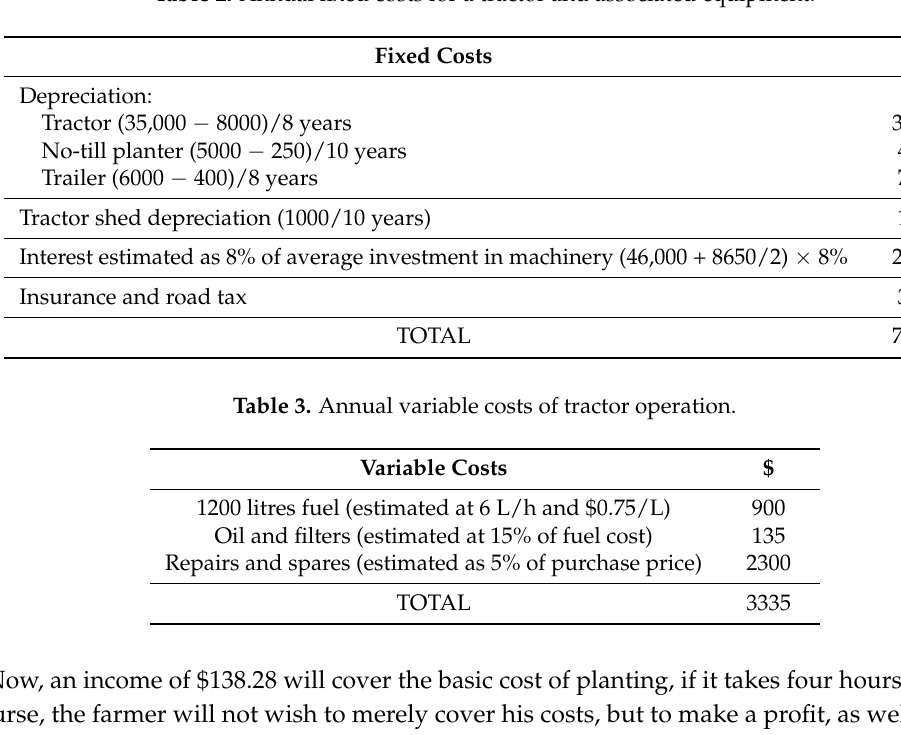
Table 2. Annual fixed costs for a tractor and associated equipment.